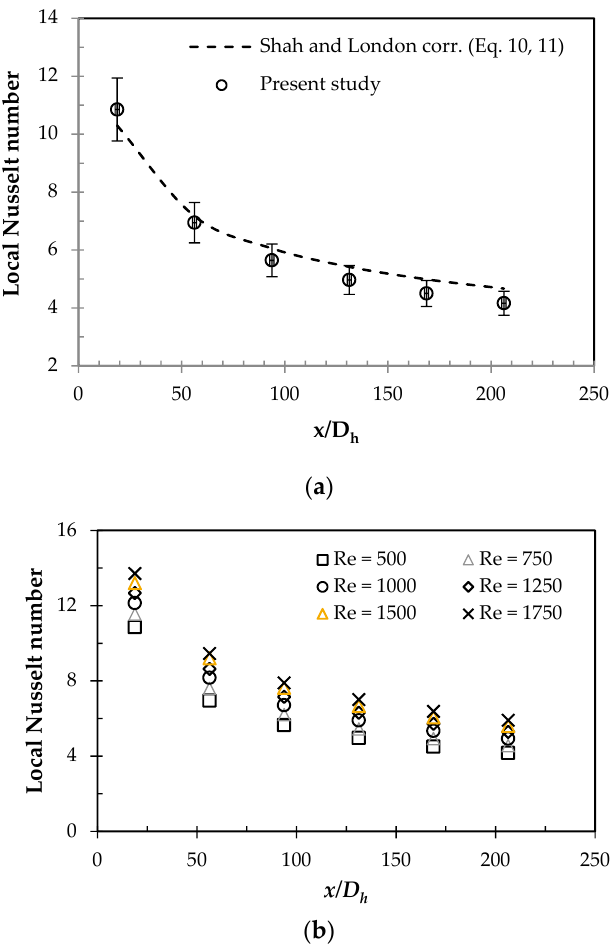
Figure 4. Thermal validation of the local Nusselt number. ( a ) The local Nusselt number versus dimensional length at Re = 500 ( b ) Numerical result of the local Nusselt number versus dimensional length at Re = 500 to 1750.